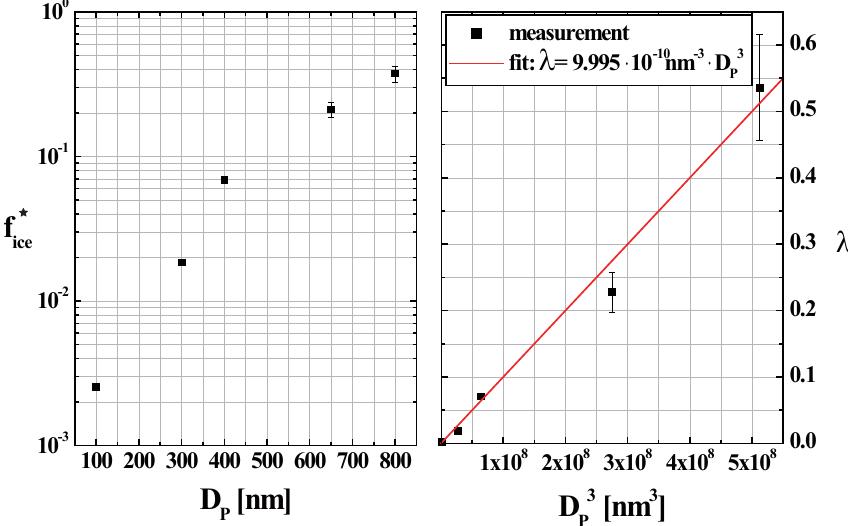
Fig. 4. Ice fraction f ? vs. mobility diameter D p (left panel) at T = − 15 ◦ C (saturation range). Measured λ and fit function describing the ice average number of INA protein complexes per particle generated from a Snomax TM solution/suspension, as function of particle volume ( D 3 (right